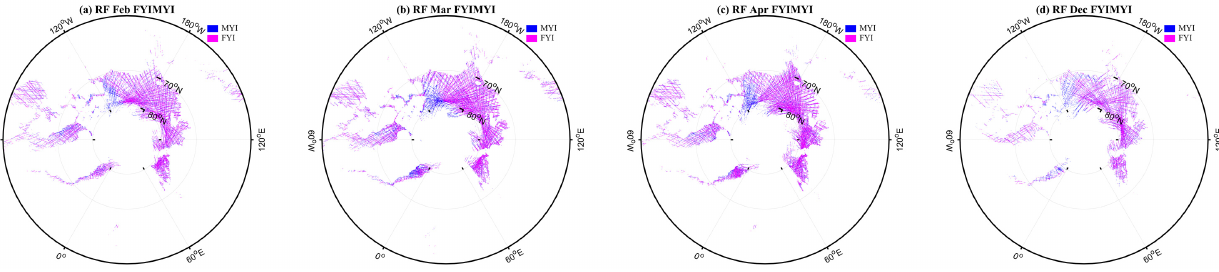
Figure A14. RF for FYI-MYI classification using the data in November as the training set. The data in ( a ) February, ( b ) March, ( c ) April, and ( d ) December are used as the test set in turn.